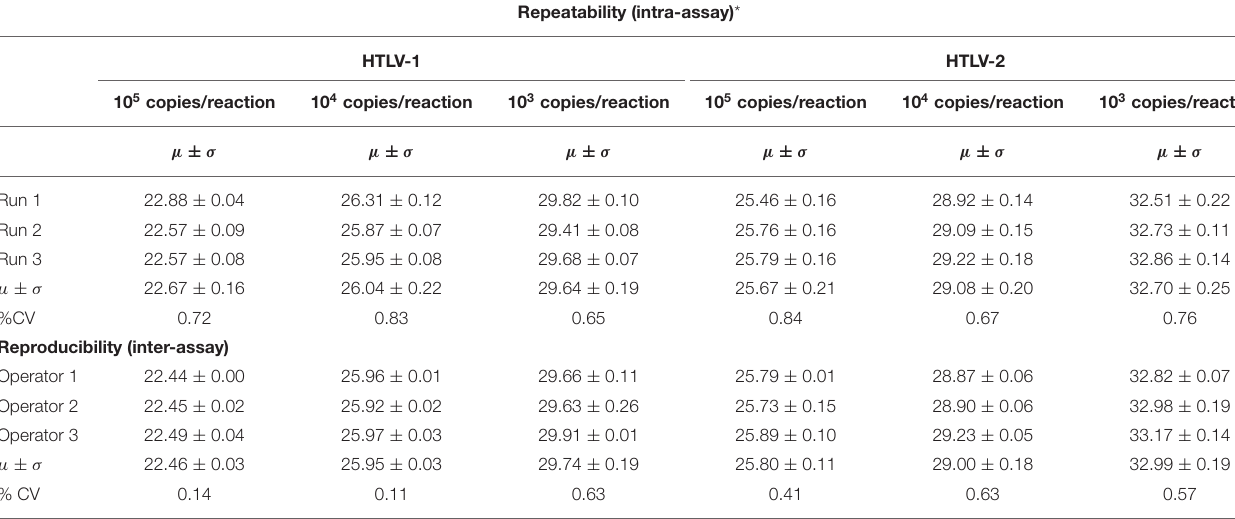
TABLE 2 | Cycle threshold (Ct) values of repeatability (intra-assay) and reproducibility (inter-assay) analysis of duoplex-RT-PCR-HTLV 1/2 based on standard templates.